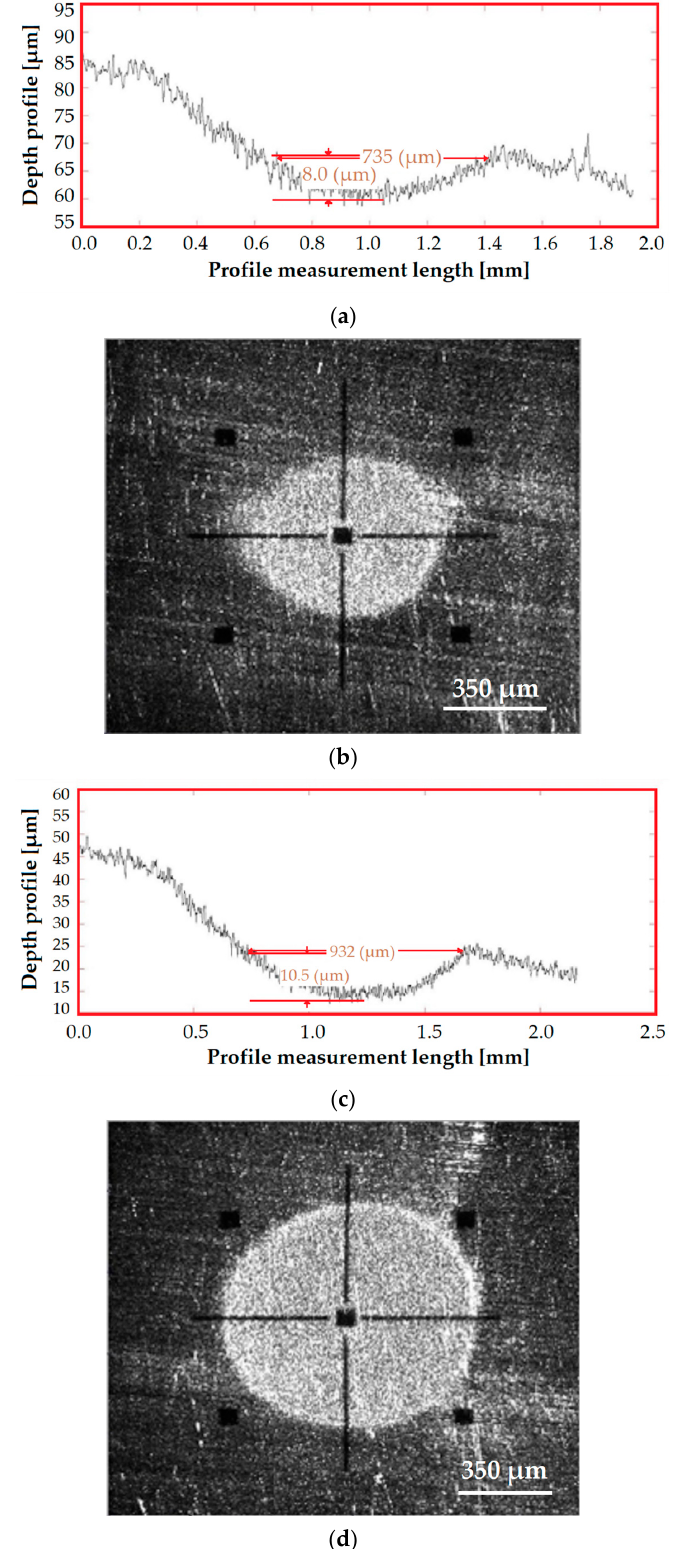
Figure 13. Profiles and microphotographs of the wells of the 20kH13 (AISI 420) steel samples after 3 min of test time (abrasion wear analyzer): ( a ) profile of the LPBF produced sample; ( b ) well image of the LPBF-produced sample; ( c ) profile of the cast sample treated by quenching with low tempering; ( d ) well image of the cast sample treated by quenching with low